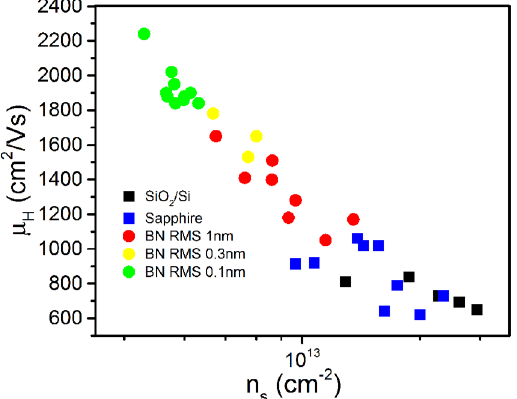
Figure 3. Room temperature Hall analysis of graphene on various dielectric substrates. Measured Hall effect mobility vs. sheet carrier